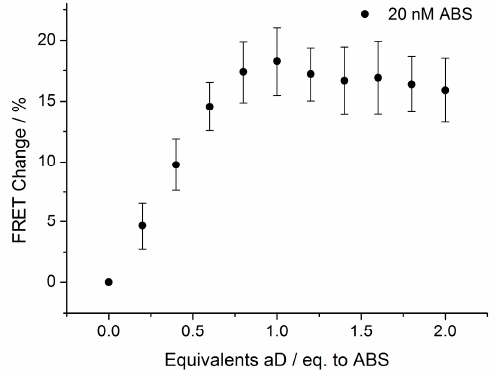
Figure 4. aD titration after 20 min of incubation. FRET change for the titration of the digoxigenin SDC assay (20 nM, A:B:S = 1:1:1) with aD. Experiment was performed in triplicate. The plotted values are mean values with standard deviations compared to the mean value. ABS and aD were incubated for 20 min before measuring the sample. Zero equivalents are defined as zero, and the FRET change is calculated on this basis.